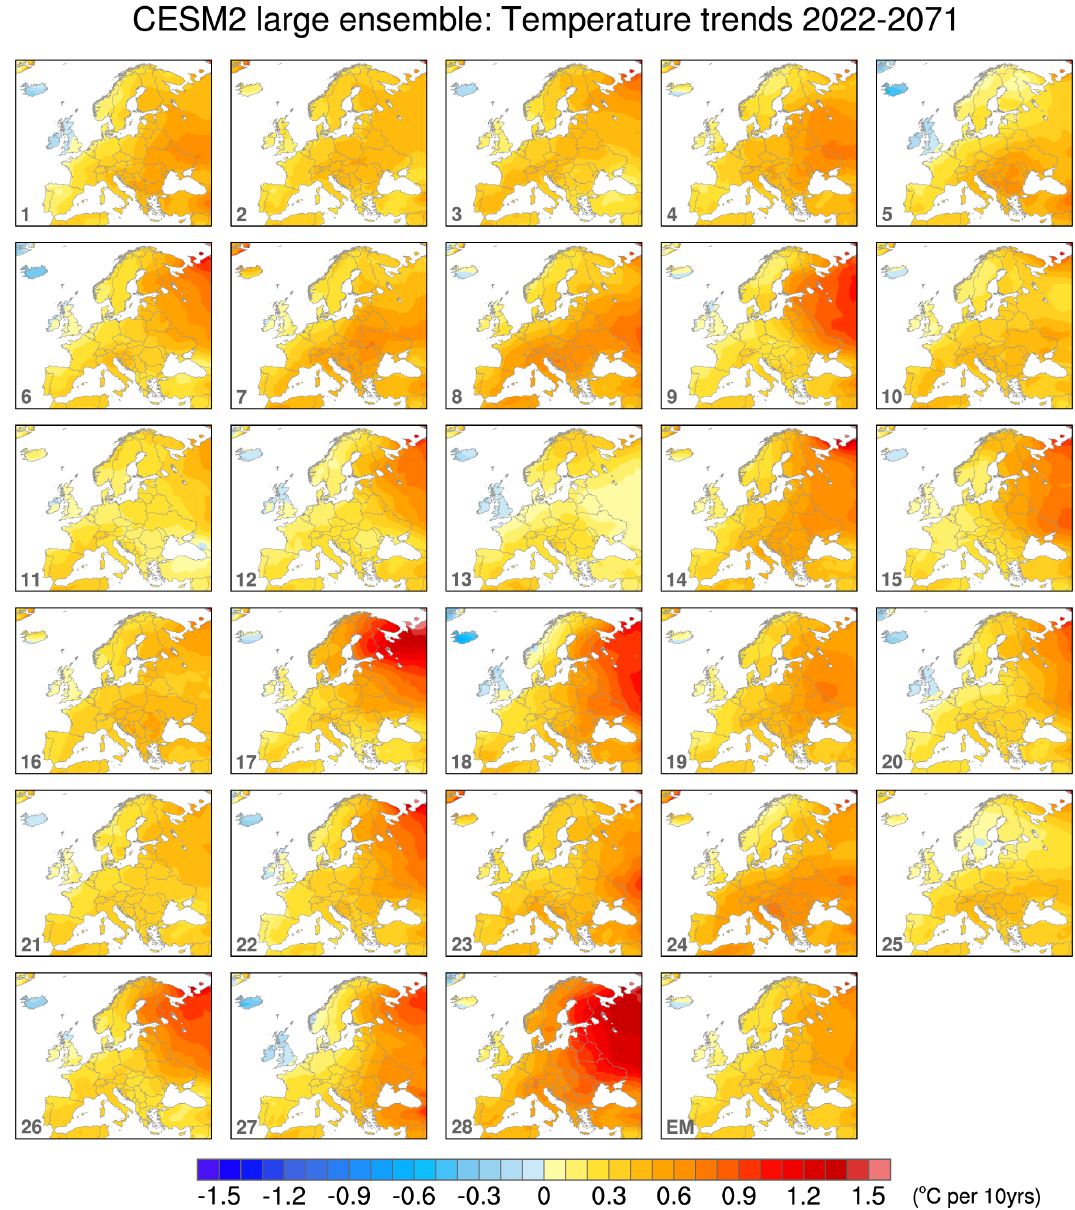
Figure 5. As in Fig. 1 but for the period 2022–2071.